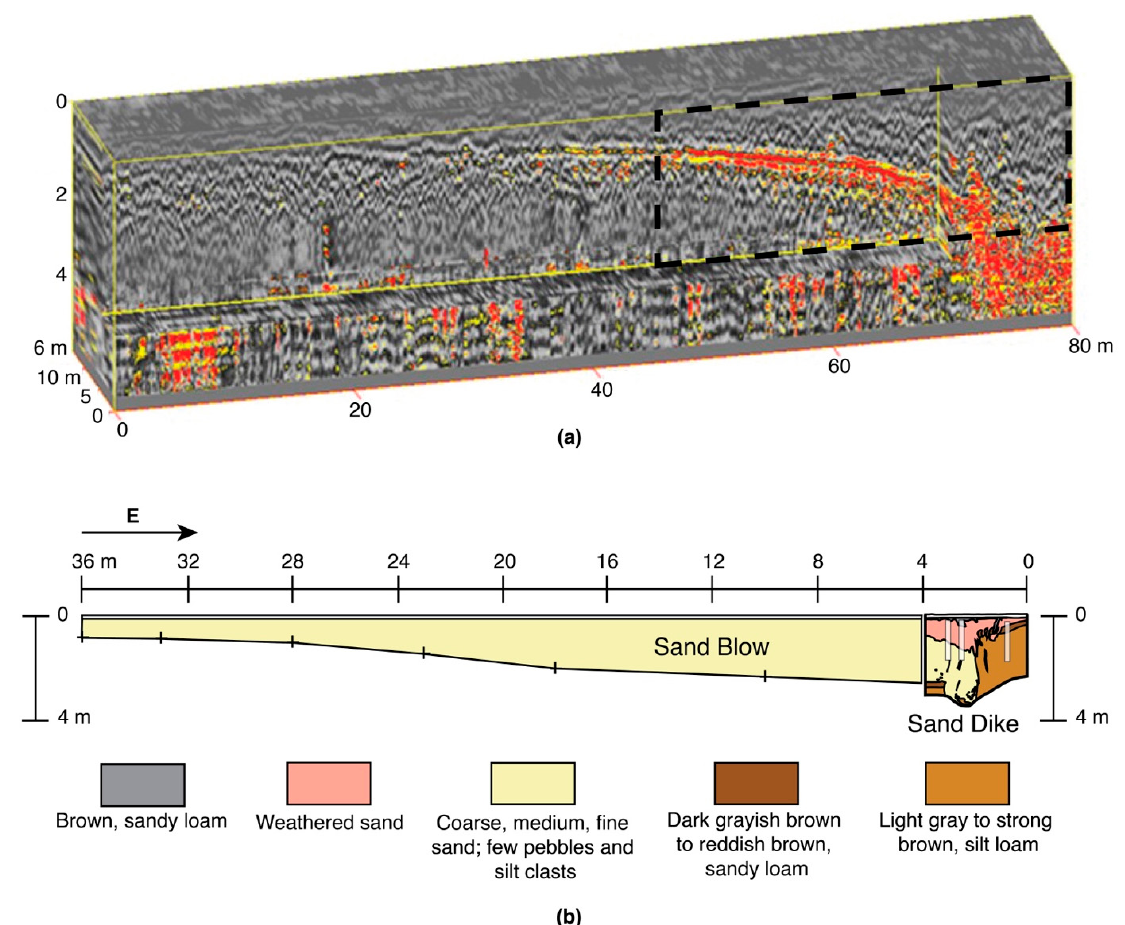
Figure 12. ( a ) Pseudo-three-dimensional (3D) ground-penetrating radar (GPR) image correlated with ( b ) log of paleoseimic trench showing large sand blow and related sand dike near Marianna, Arkansas [122]. Area of trench log is outlined on ( a ) with a dashed rectangle.